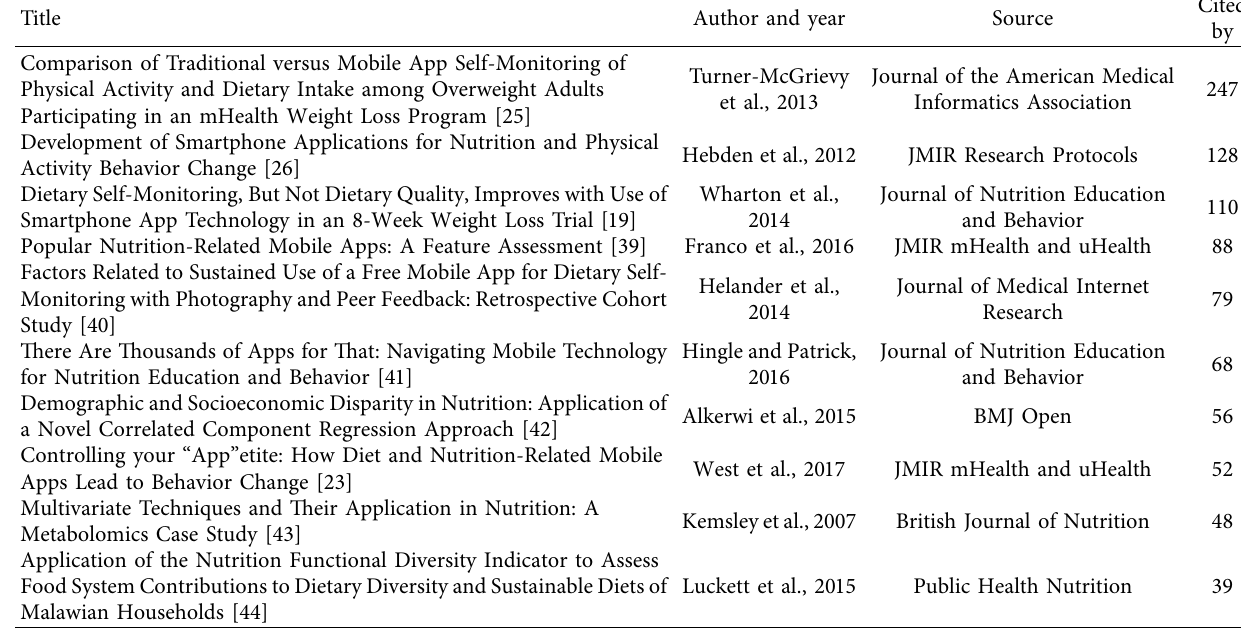
Table 3: Top article citations.